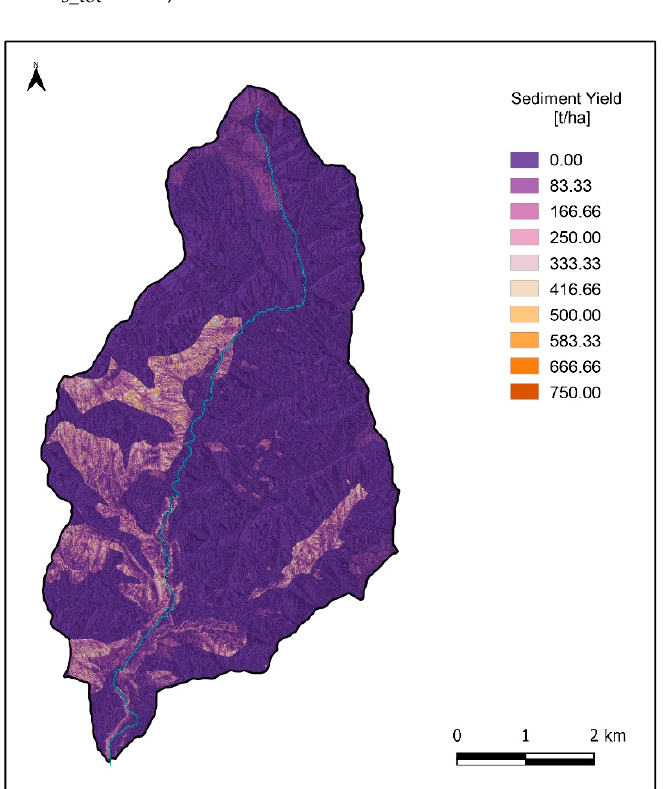
Figure 10. Guerna catchment: map of computed sediment yield (Y s ) applying MUSLE model (4 September 2011 rainfall event and using AMC II to generate surface runoff) without considering climate change.